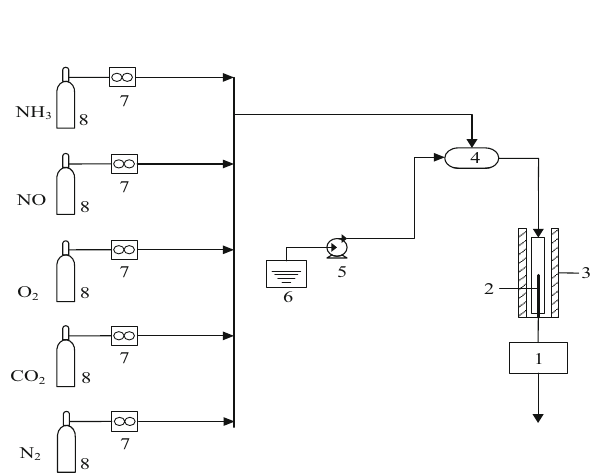
Fig. 1 Experimental system used for SCR. 1. Mass spectrometer; 2. Quartz tube; 3. Resistance furnace; 4. Vaporizer; 5. Gas mixing tank; 6. Water tank; 7. Mass flow meter; 8. High Pressure steel